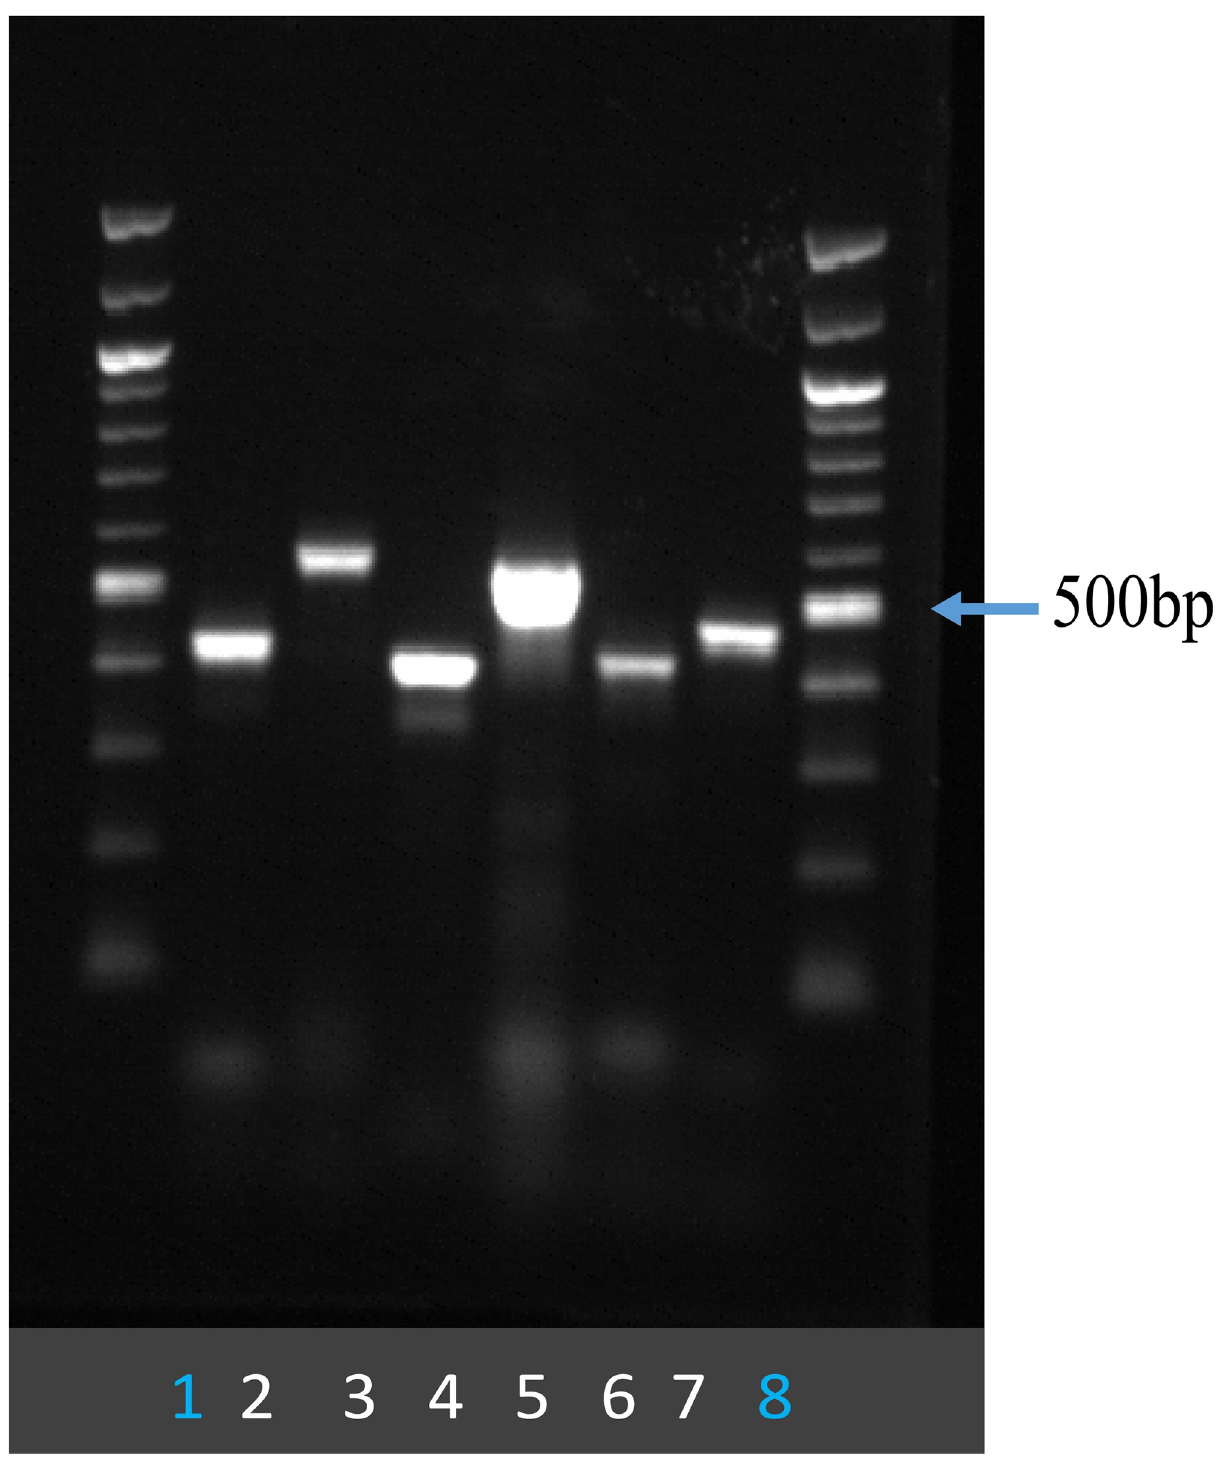
Fig 10. Agarose gel picture showing the result of PCR performed using cell-free culture supernatant. DNA template used in PCR was cell-free culture supernatant of wild type C . jejuni strain 81–176 with the primer sets targeting six genomic loci; 5 μ l of PCR mix was loaded onto the gel. Lane 1 and 8 represent 100kb ladder. Lane 2 to 7 represent the PCR products from ciaB , motAB , docB , kpsE , cstII and CJJ81176_RS02890 regions, respectively.